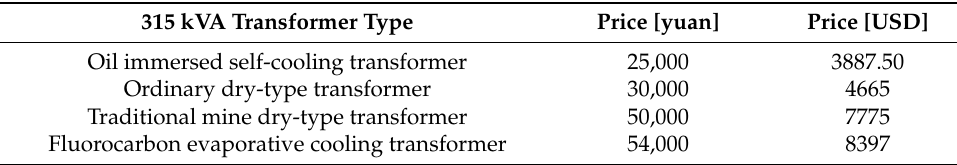
Table 4. Price of 315 kVA